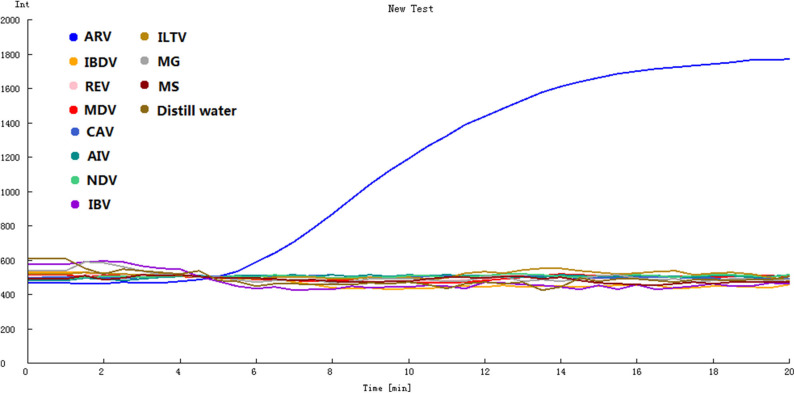
Specificity of the real-time RT-RPA assay. IBDV, REV, MDV, CAV, AIV, NDV, IBV, ILTV, MG, MS were tested by the assay. ARV was detected by the assay as the positive control, and distilled water was the negative control.